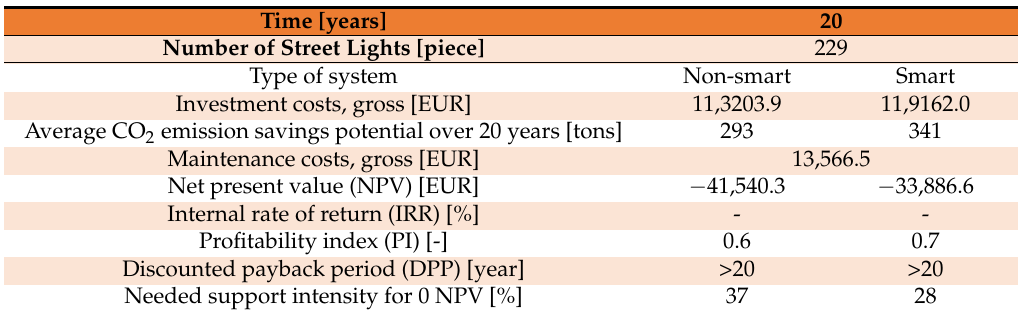
Table 4. Only street lighting development: without smart lighting system with 60% energy saving and with smart lighting system with 70% energy